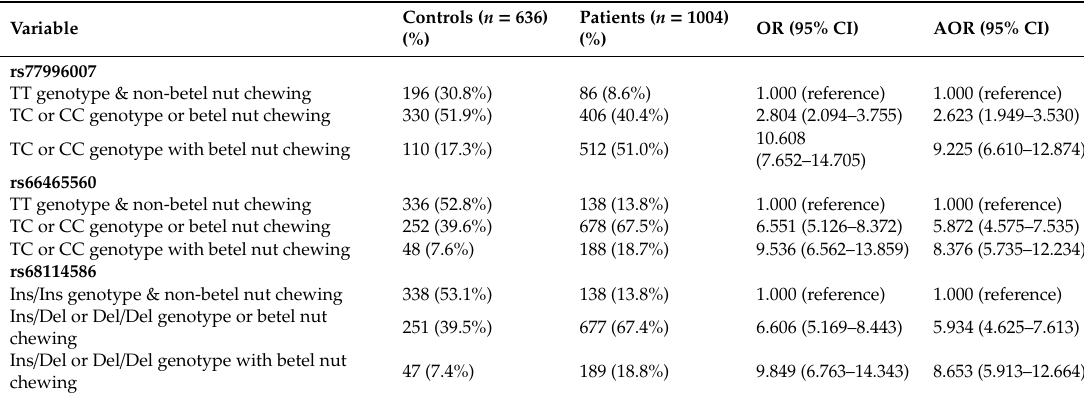
Table 3. Associations of the combined e ff ect of SOX11 gene polymorphisms and betel nut chewing with the susceptibility to oral cancer among 1640